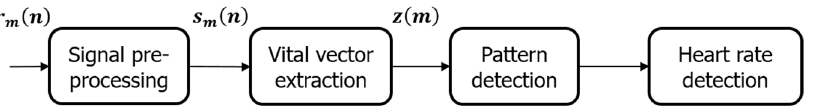
Figure 1. System